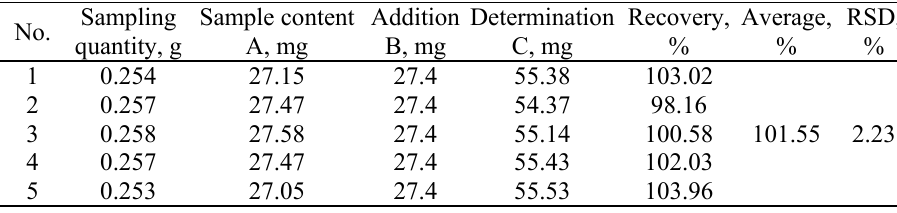
Table 1. Recovery rate of arctiin